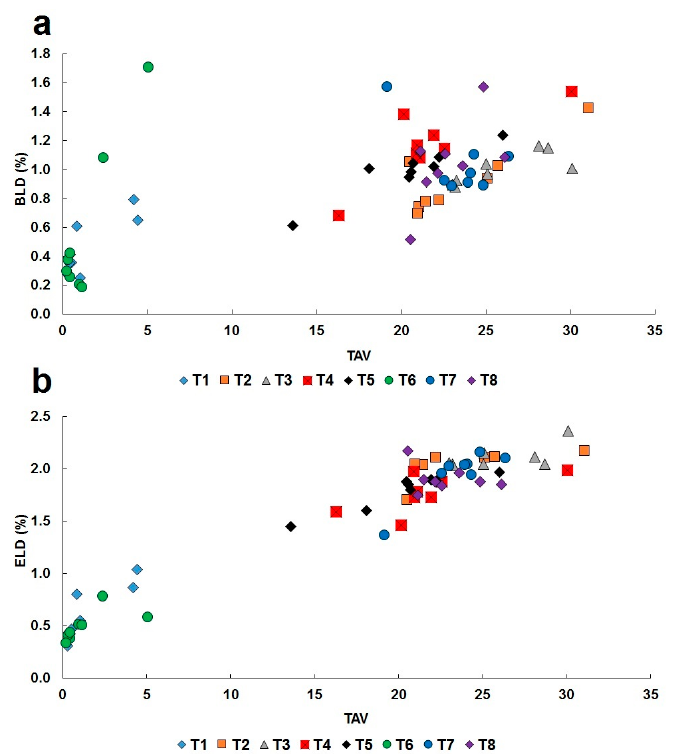
Figure 8. Relations between TAV (tetrahedral angle variance) and BLD (bond length distortion) ( a ) and ELD (edge length distortion) ( b ) for tetrahedral in fedorite under study (sample Gav-43, Yak-5, Irk-53, Murun complex), fedorite from Murun and Turiy complexes [7], lalondeite [39], martinite [40] and ellingsenite [41]. Data were taken from Table S11 in the Supplementary